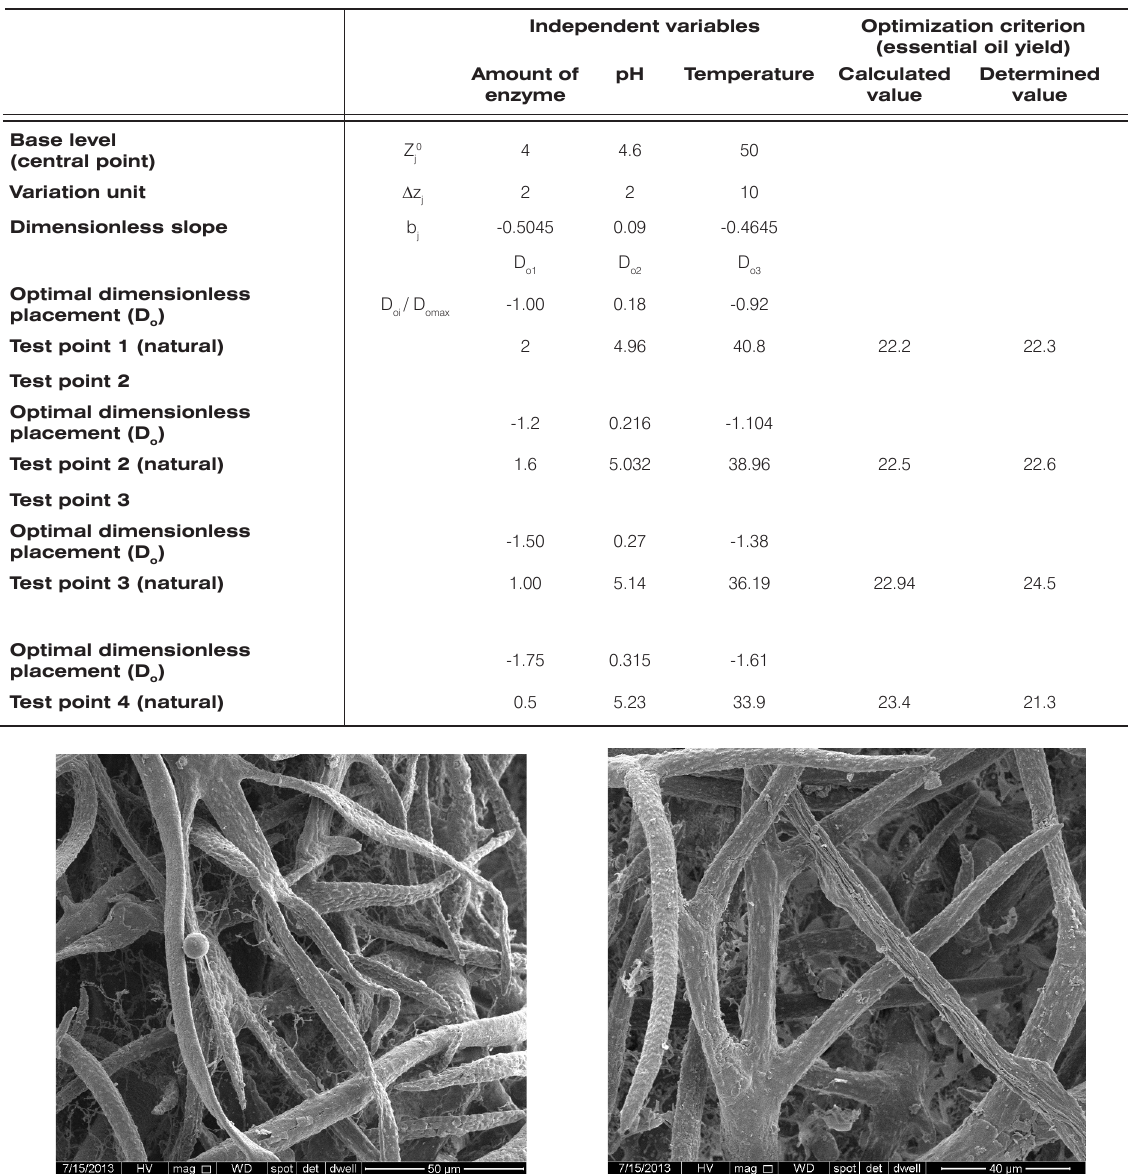
Table 6. Exploration of the experimental domain outside of the initial factorial experiment.